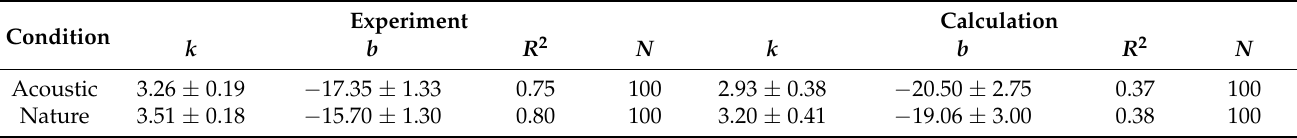
Table 3. Linear fitting parameters.